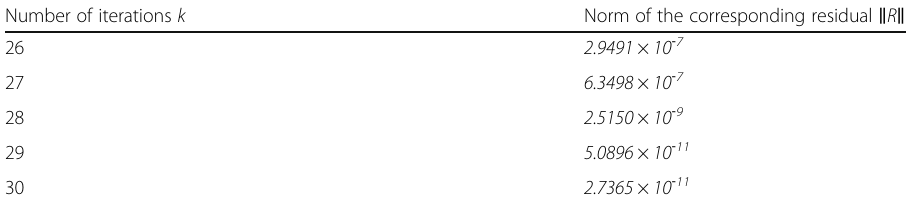
Table 2 The number of iterations and norm of the corresponding residual for Example 4.1 with V 1 ¼ W 1 ¼ 0 Number of iterations